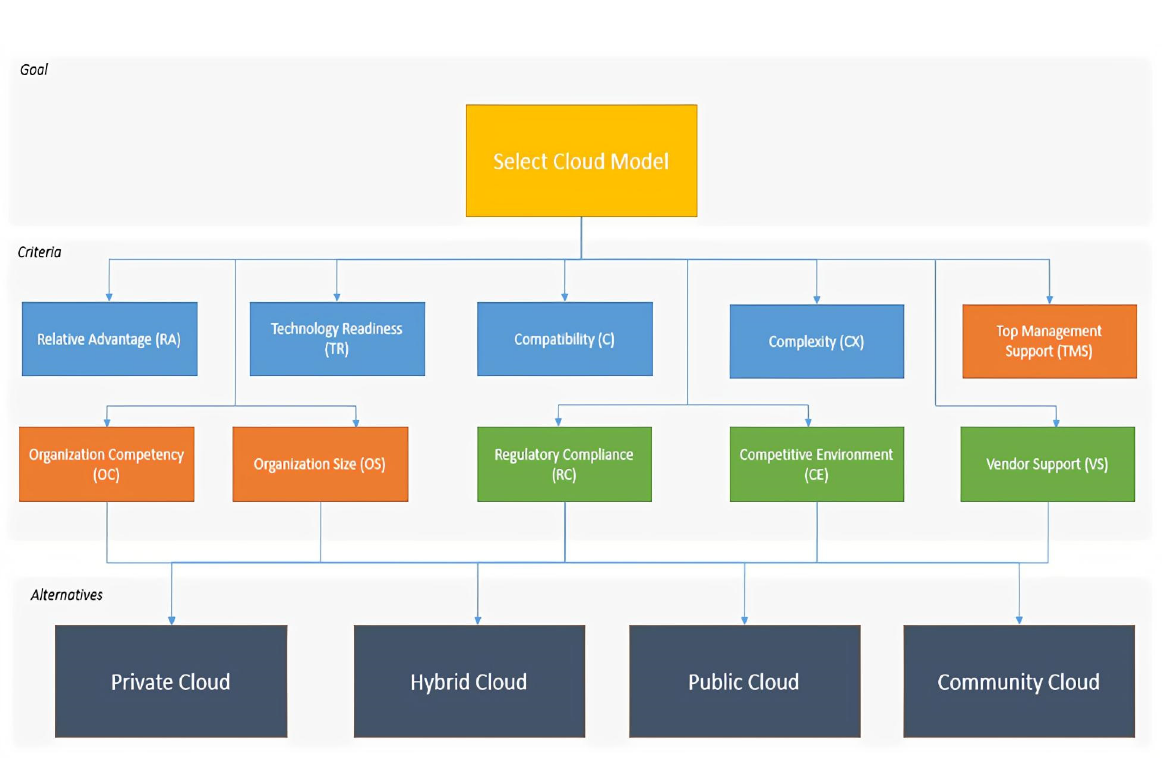
Figure 11. Cloud deployment model.